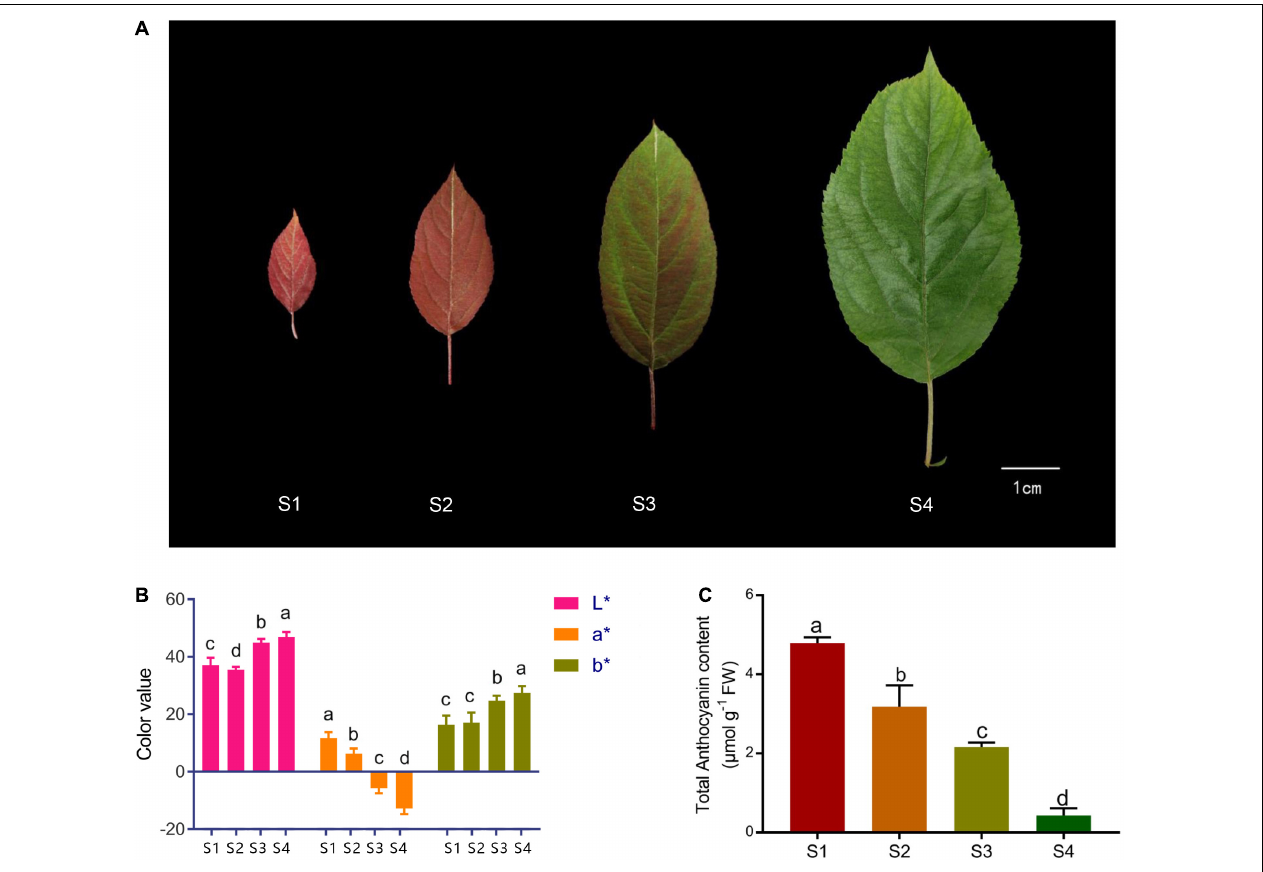
FIGURE 1 | Phenotype and total anthocyanin content at different stages of spring leaf development in Malus ‘Radiant.’ (A) Leaf color at four stages (S1–S4). (B) L ∗ , a ∗ , and b ∗ values of leaves at four stages. (C) Total anthocyanin content at four stages (FW, fresh weight). Error bars represent the standard errors. Different lowercase letters indicate significant differences among treatments according to one-way ANOVA test ( P <